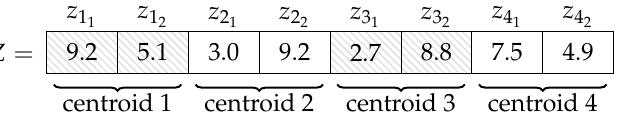
Figure 4. An example of an object in the system, with values K = 4 and d =